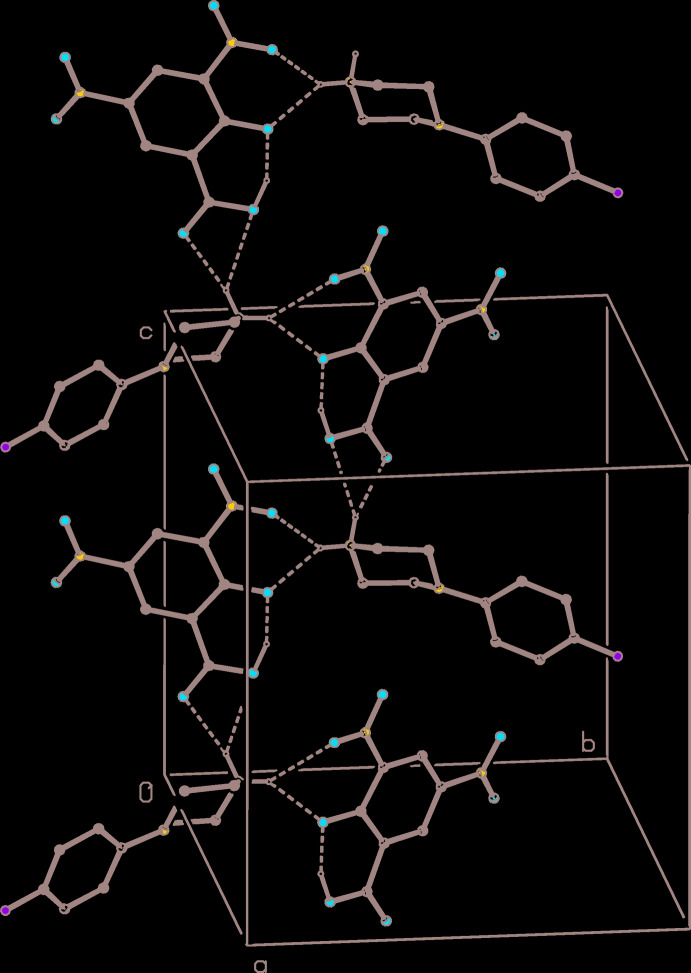
Part of the crystal structure of compound (I) showing the formation of a hydrogen-bonded chain of rings running parallel to [001]. Hydrogen bonds are drawn as dashed lines and, for the sake of clarity, the H atoms bonded to C atoms have been omitted.